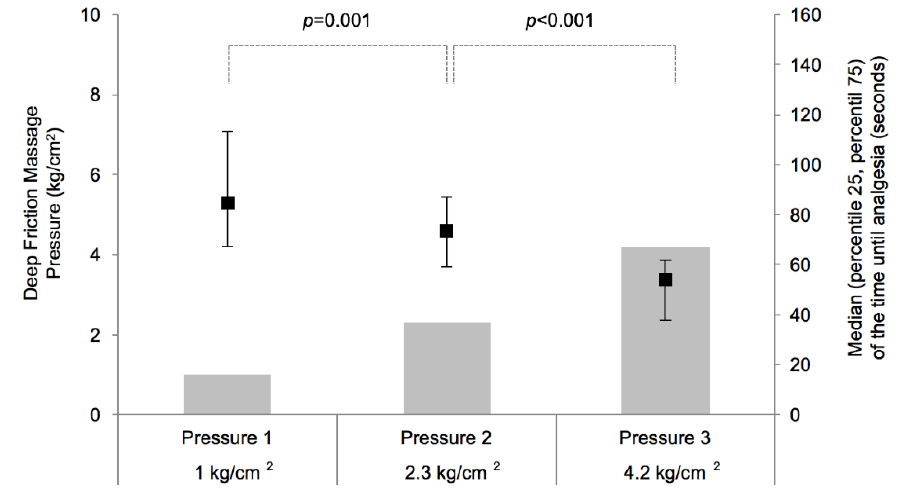
Figure 4. Deep friction massage pressure and the corresponding median (P25; P75) of the time until analgesia.